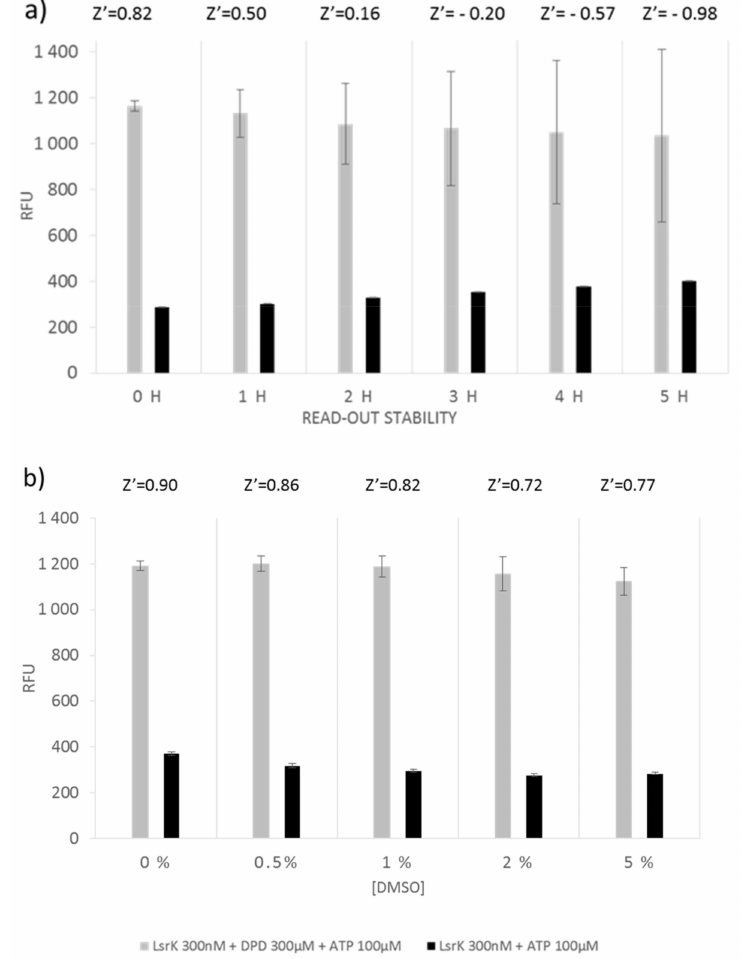
Figure 2. Optimization of LsrK high-throughput screening assay by using the ADP-Quest kit: ( a ) evaluation of the stability of the read-out within a time window of 5 h; ( b ) e ff ect of di ff erent DMSO concentration on the